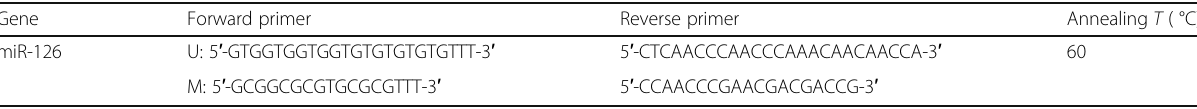
Table 1 Primer sequence and the annealing temperature used for methylation-specific PCR Gene Forward primer Reverse primer